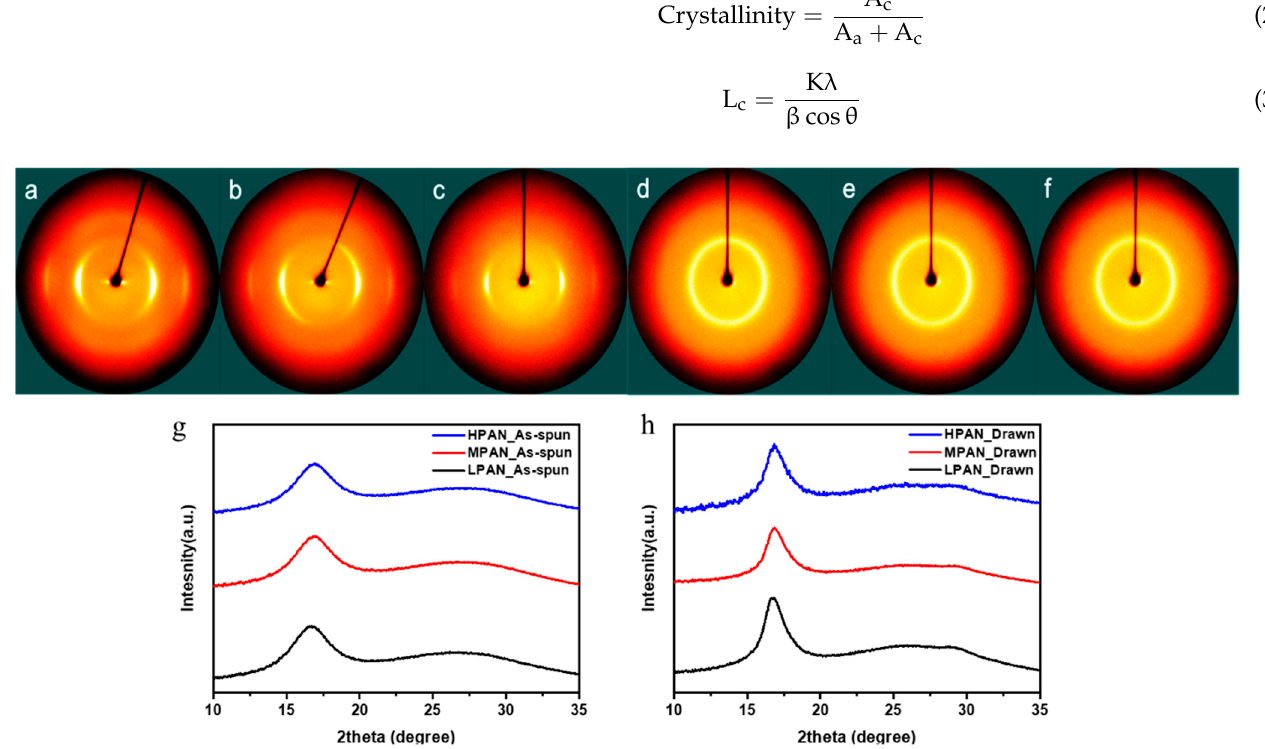
Figure 7. Two-dimensional wide-angle X-ray diffraction (WAXD) images of P(AN-co-MA) precursor fibers; ( a ) as-spun LPAN, ( b ) as-spun MPAN, ( c ) as-spun HPAN fiber, ( d ) drawn LPAN, ( e ) drawn MPAN, ( f ) drawn HPAN fiber, ( g ) 1D equatorially extracted XRD plot of as-spun fibers and ( h ) 1D equatorially extracted XRD plot of drawn fibers. Table 2. Microstructural characterization results of PAN fibers.